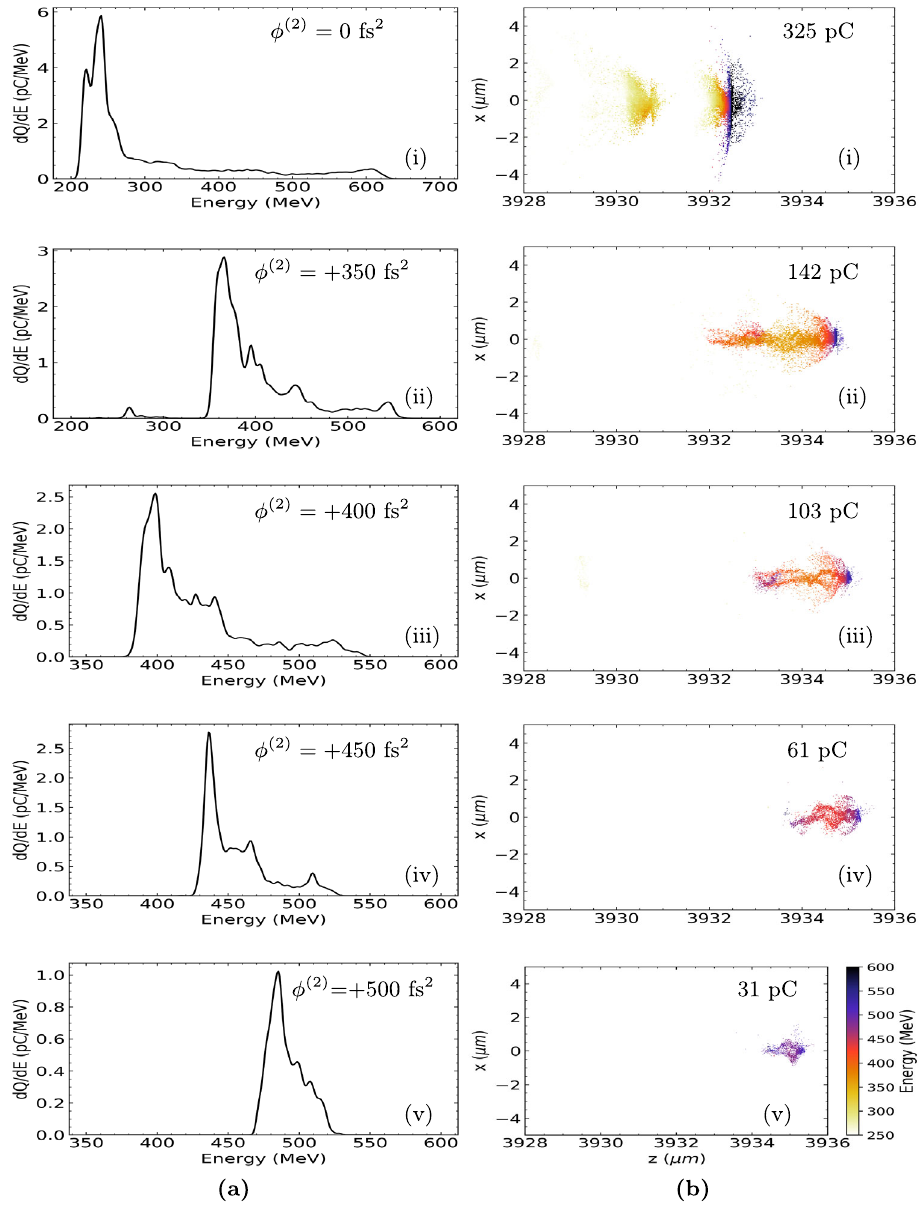
FIG. 2. (a) Energy spectra for injected electron obtained with different values of the group delay dispersion ( ϕ ð 2 Þ ) of the laser pulse. (b) The distribution of electron bunch is represented corresponding to each ϕ ð 2 Þ , where the color scheme represents the energy gain by the injected